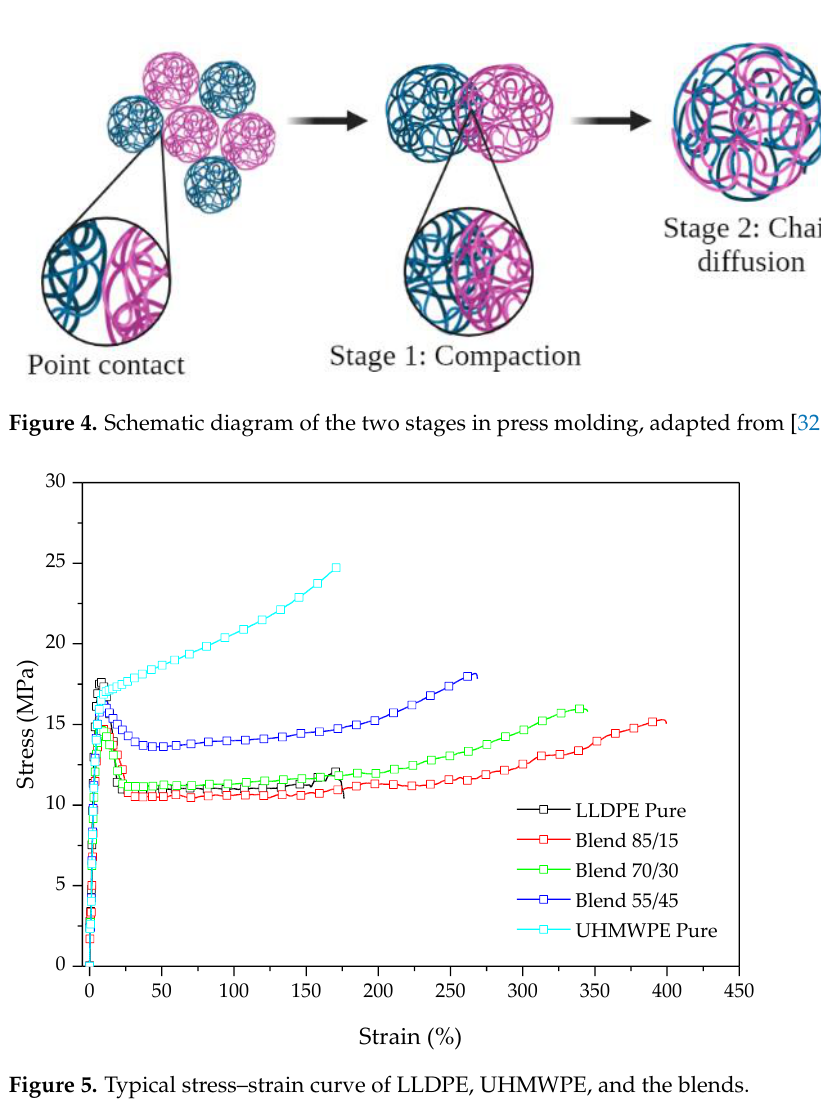
Figure 5. Typical stress–strain curve of LLDPE, UHMWPE, and the blends. Table 3. Tensile test data of LLDPE, UHMWPE, and blends. Figure 6. X-ray diffractograms of UHMWPE and the blends.